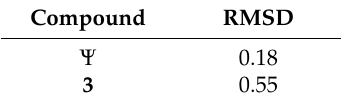
Table 6. Calculated RMSD of minimized B3LYP/6-31G* compounds from crystal structures.